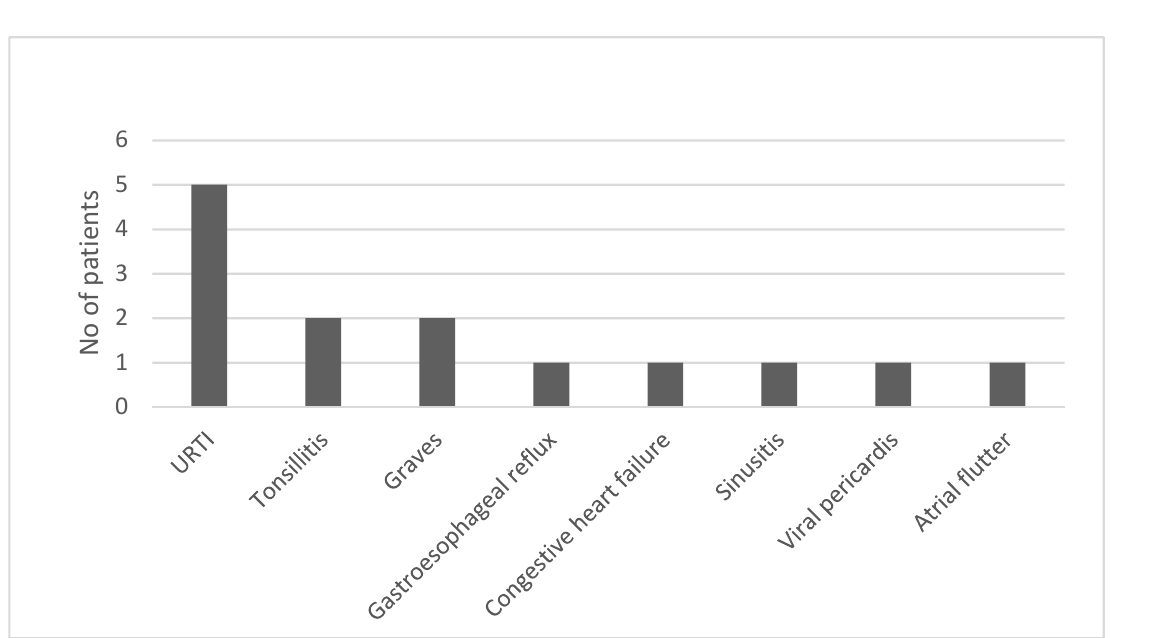
Figure 2. Investigations performed in search of an alternative diagnosis ( n = 38).